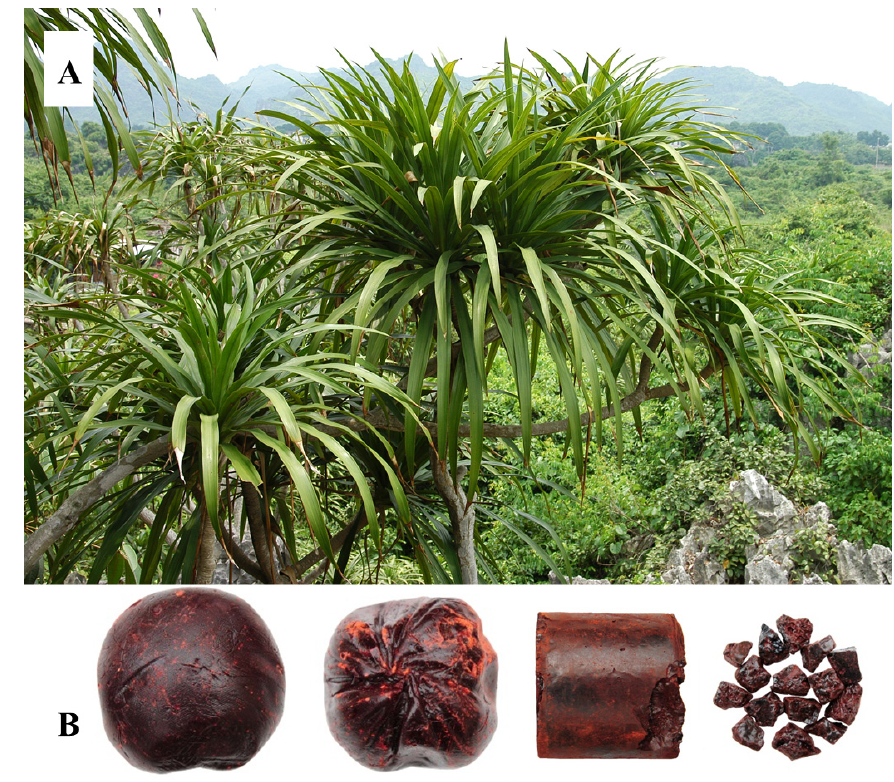
Figure 1. Photos of Dracaena cochinchinensis plant ( A ) and “Dragon’s Blood” medicinal materials ( B